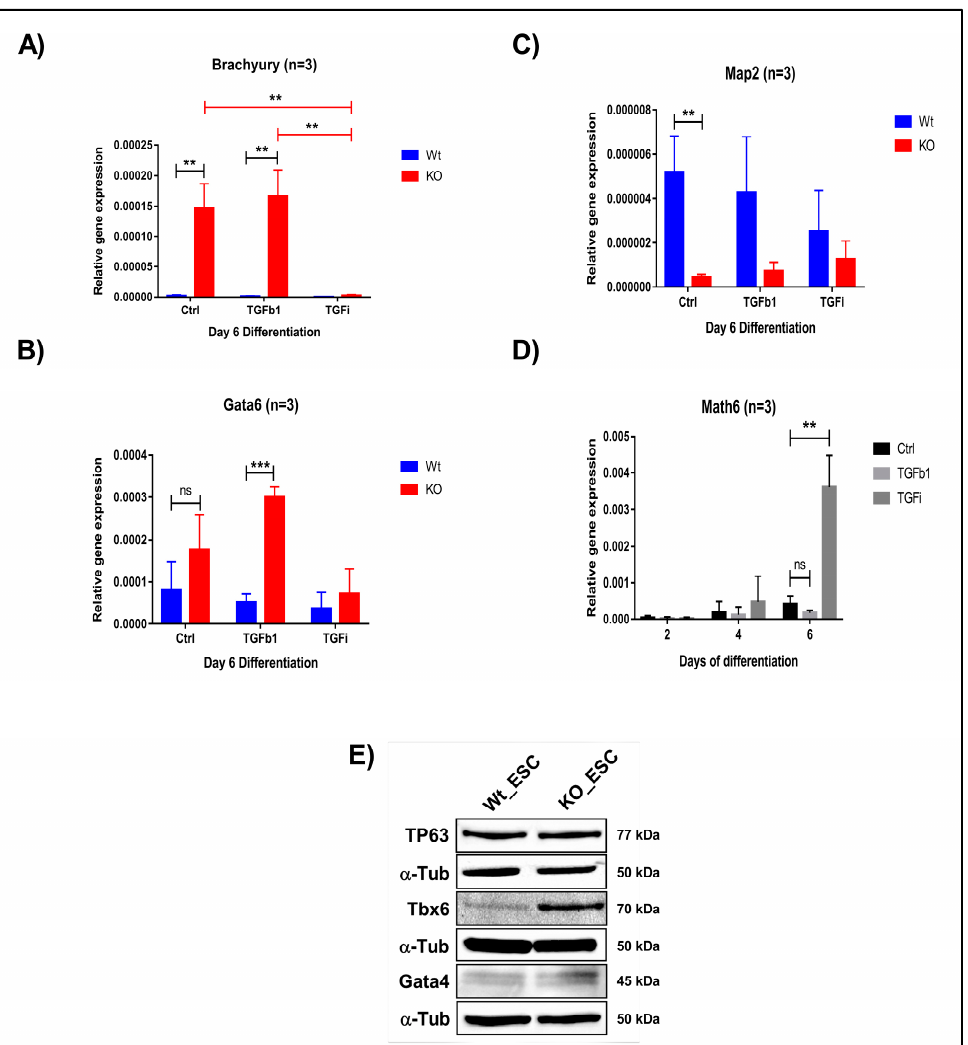
Figure 7. Math6 regulates the stem cell fate by influencing TGF- β signalling. ( A ) Expression of the mesodermal marker (Brachyury) during di ff erentiation of WT-ESCs and KO-ESCs on day 6 under the following conditions: Ctrl, TGFb1-treated, SB-431542-treated. The gene expression shown is relative to 18s . ( B ) Expression of the endodermal marker (Gata6) during day 6 of di ff erentiation WT-ESCs and KO-ESCs in following conditions Ctrl, TGFb1 treated, SB-431542 treated. The gene expression shown is normalized to 18s . ( C ) Expression of the ectodermal marker (Map2) during di ff erentiation of WT-ESCs and KO-ESCs on day 6 under the following conditions: Ctrl, TGFb1-treated, SB-431542-treated. The gene expression shown is relative to 18s . ( D ) Expression of Math6 during di ff erentiation from day 2-6. The Math6 expression is inhibited by TGFb1 and TGF- β inhibition resulted in the upregulation of Math6 expression on day 4 and 6 of di ff erentiation. Significance levels are shown as (ns) no significance p > 0.05, * p ≤ 0.05, ** p ≤ 0.01 and *** p ≤ 0.001 ( E ) Western blot analysis showing the presence of germ layer markers for ectoderm (TP63), mesoderm (Tbx6) and endoderm (Gata4). α -Tubulin is used as a